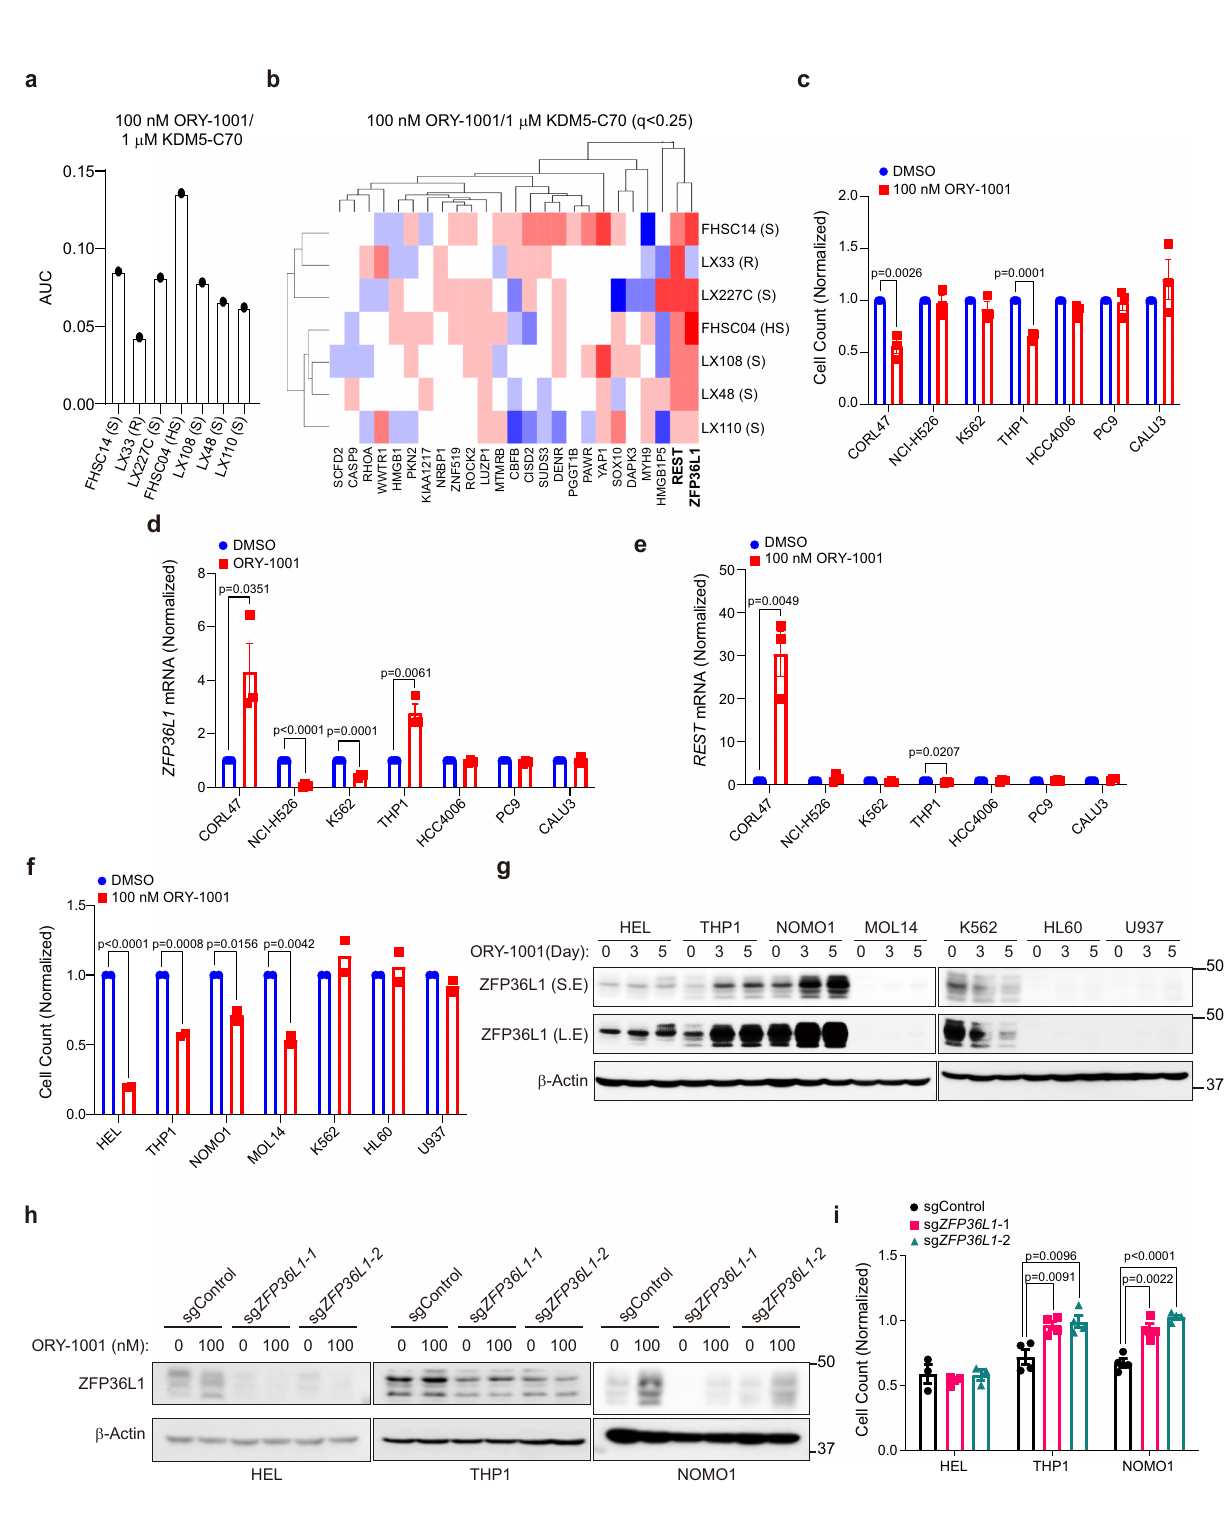
Fig. 6 | Restoring endogenous ZFP36L1 expression promotes non- neuroendocrine plasticity toward an “ in fl ammatory ” phenotype. a , b Volcano plotofRNA-sequencing(RNA-seq)datashowingthelog2fold-changeand – log10 p - value of gene expression comparing CORL47 dCas9-VP64 cells expressing sgRNAs targeting the promoter of ZFP36L1 [sgZFP36L1-1 ( a )orsgZFP36L1-2 ( b )]to activate endogenous ZFP36L1 expression or a non-targeting sgRNA (sgControl). For a , b n =2 biological independent experiments. c – f GSEA of RNA-seq data in a (top) or b (bottom) of epithelial – mesenchymal transition ( c ), interferon gamma